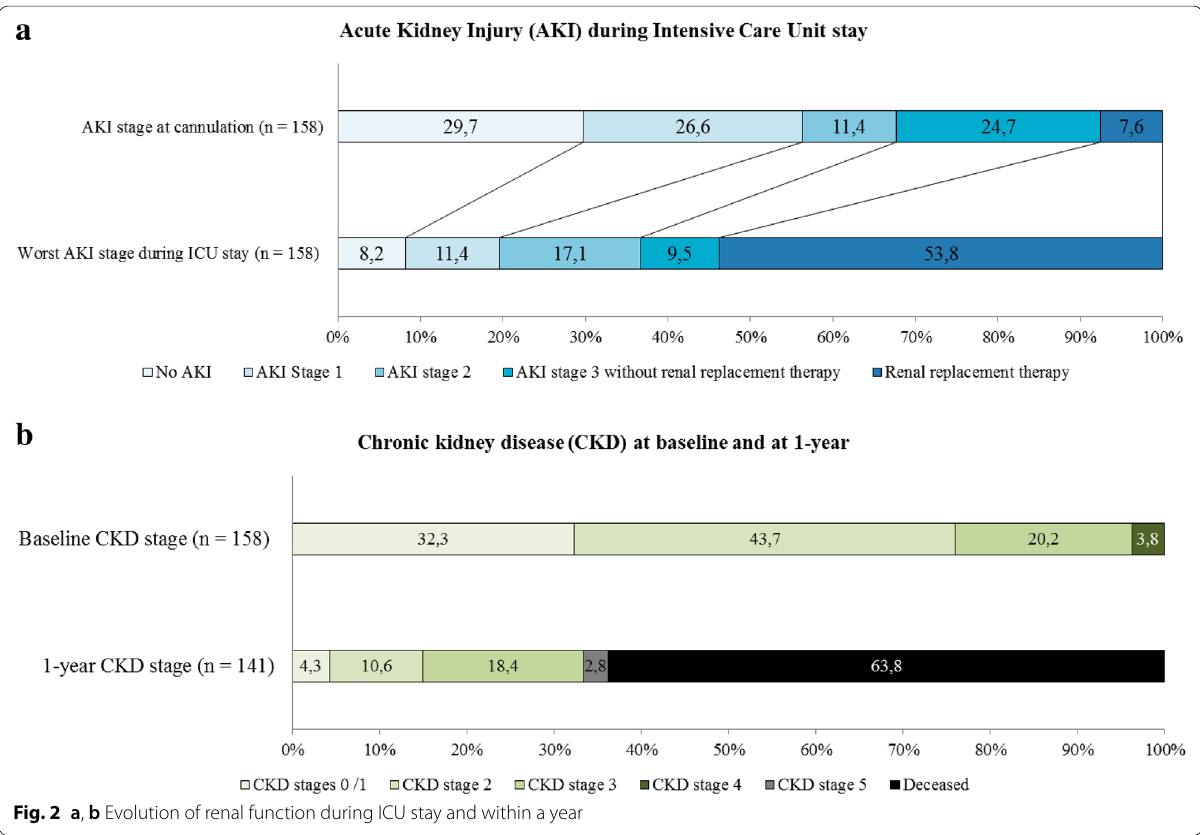
Fig. 2 a , b Evolution of renal function during ICU stay and within a year